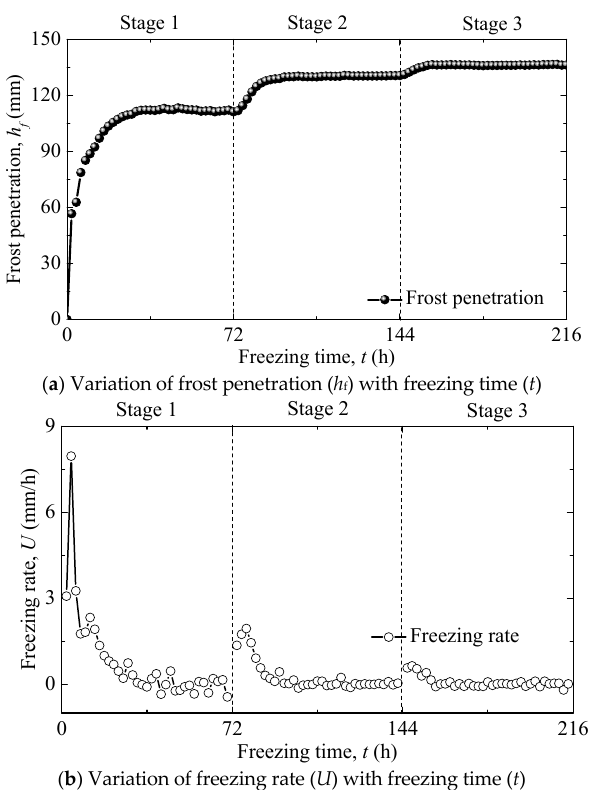
Figure 7. Variation of ( a ) frost penetration and ( b ) freezing rate of soil columns with freezing time ( t ) in tests FT1–FT5.